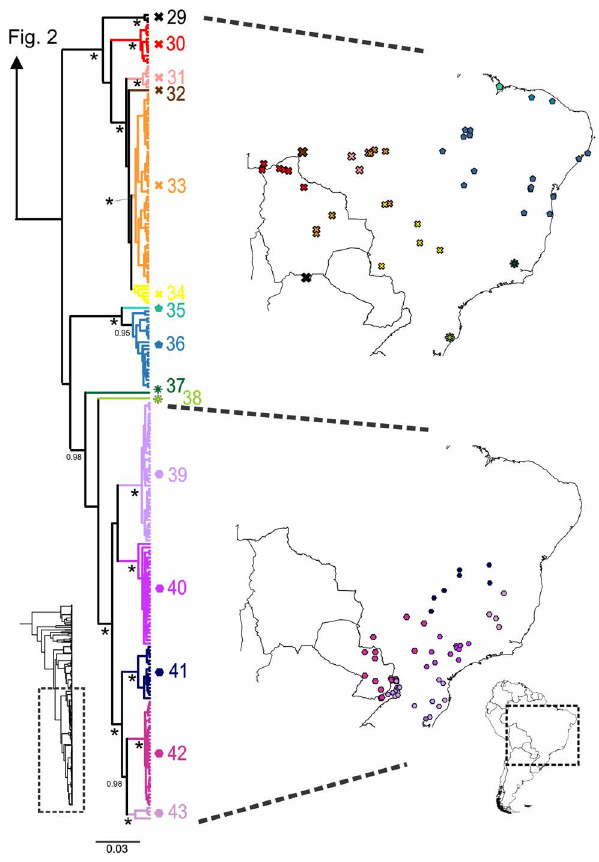
Figure 3. Dendropsophusminutus tree with lineage distribution part 3. 50% Maximum Clade Credibility tree and distribution maps of mtDNA lineages 29–43. Asterisks represent nodes with probability equals to 1. Probabilities lower than 0.9 are not